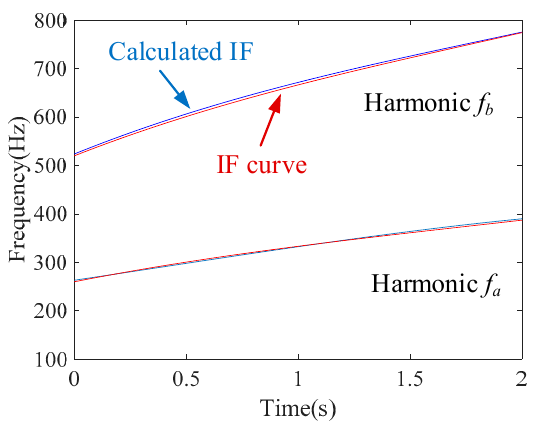
Figure 15. Estimated IF curves and theoretical IF curves.